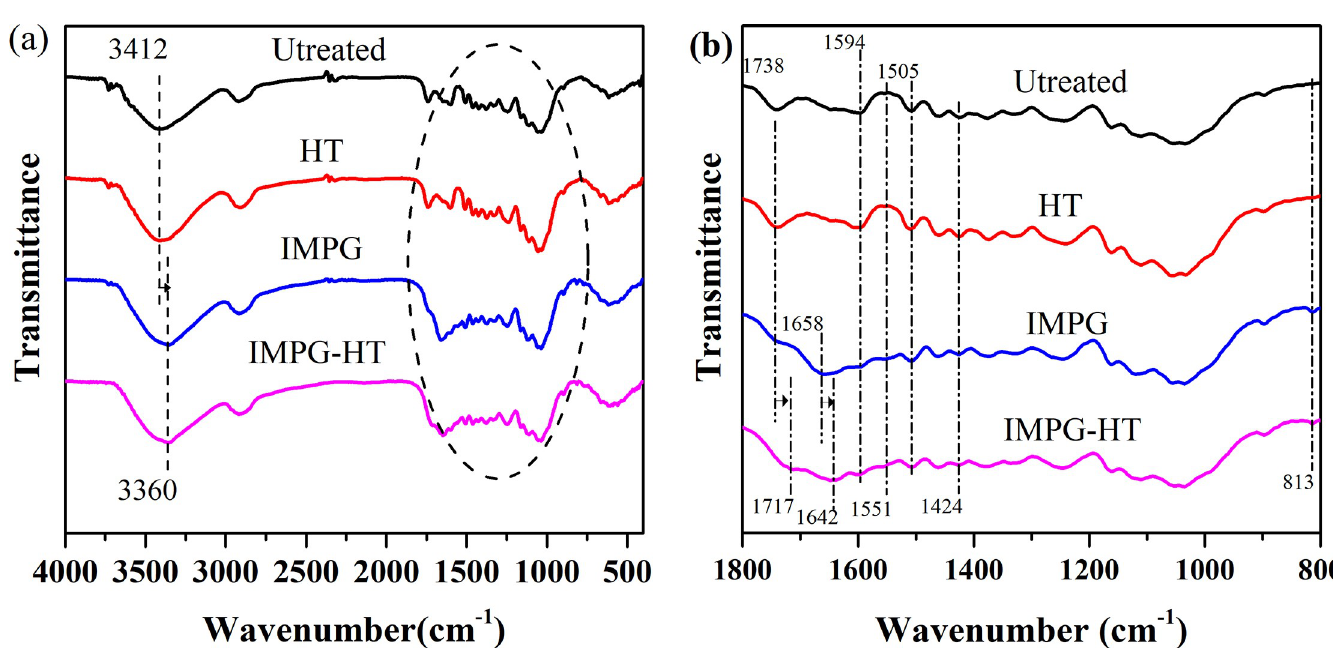
Fig 2. FTIR spectrum for samples. (a) FTIR spectrum in the range of 4000-400cm -1 ; (b) The amplified FTIR spectrum in the range of 1800-800cm -1 .